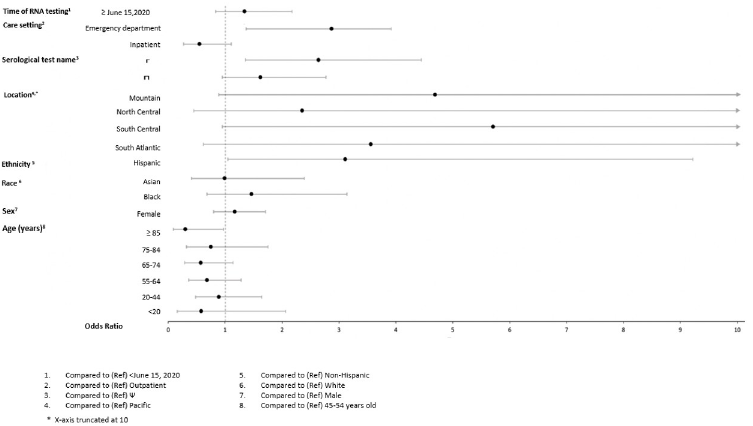
Fig 8. Odds of seropositivity dataset